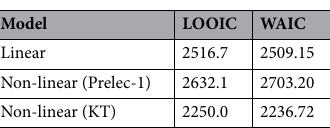
Table 3. LOOIC and WAIC information criteria to determine the best fitting model.